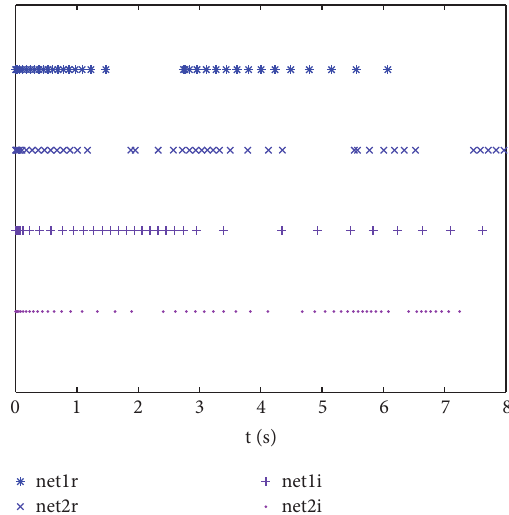
Figure 7: The event-triggered time instants t i